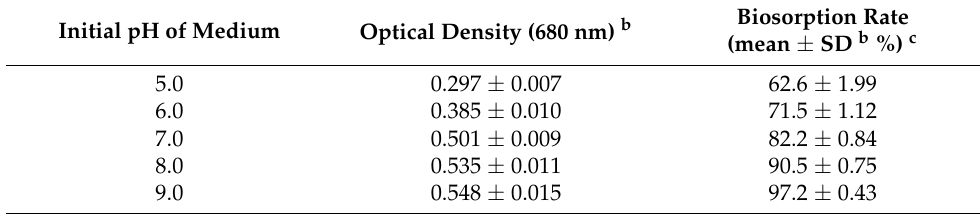
Table 1. The effect of medium pH on the growth of AA1 cells and their rate of U(VI) biosorption a